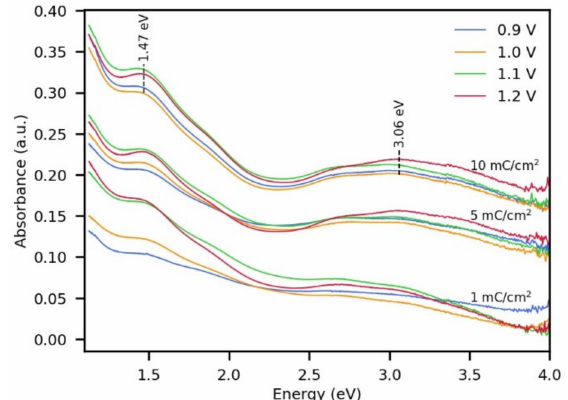
Figure 6. UV-Vis spectra of PPy deposited on FTO under control of electric charge and potential during the synthesis.